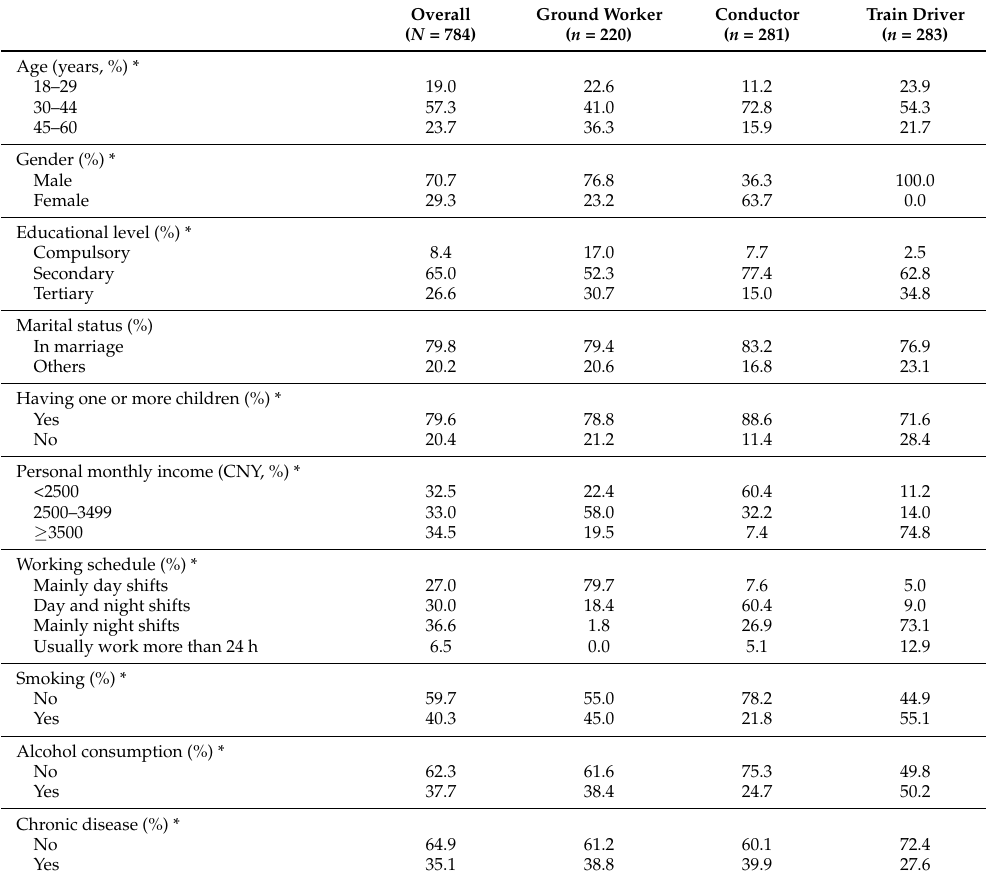
Table 1. Characteristics of participants #